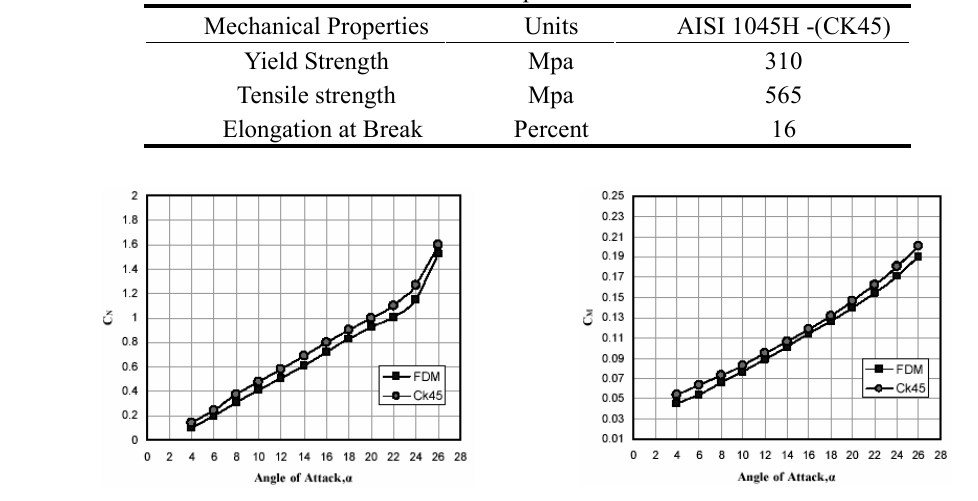
Fig. 4 Comparison of pitching moment coefficient at Mach 0.3